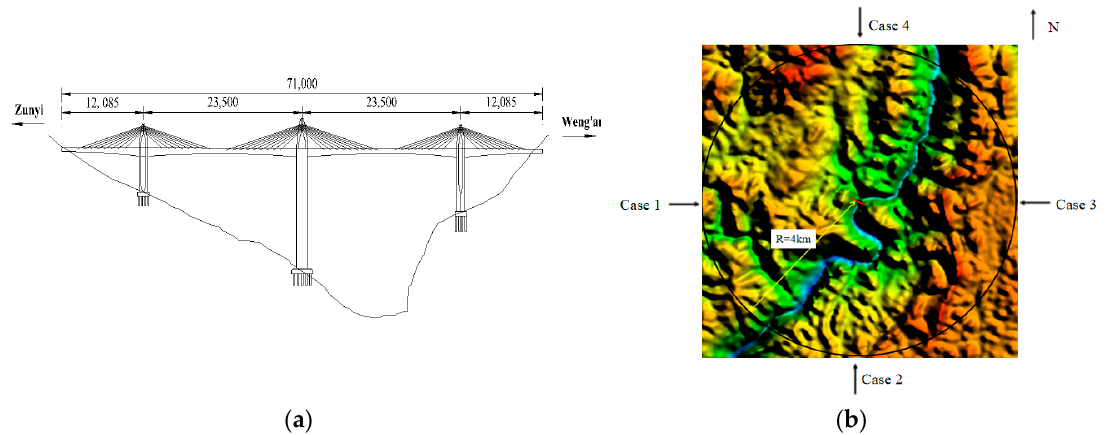
Figure 3. Elevation of the Xiangjiang Bridge and the mountainous terrain (Unit: cm). ( a ) Elevation of the Xiangjiang Bridge; ( b ) Complex terrain at the bridge site.